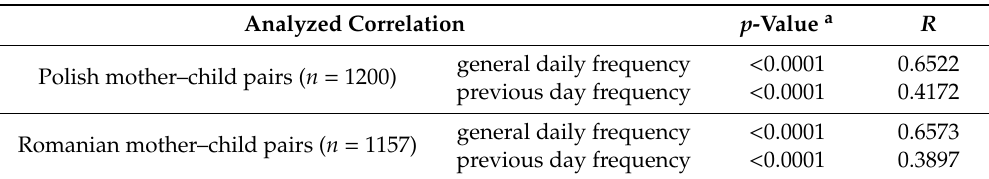
Table 1. Analysis of the correlation between the daily frequency of vegetables consumption of mothers and of their children in nationally representative samples of Polish ( n = 1200) and Romanian ( n = 1157) mother–child pairs.